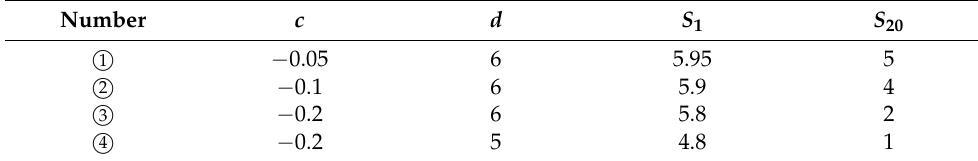
Table 5. The assignment of c , d for the decreasing trends.